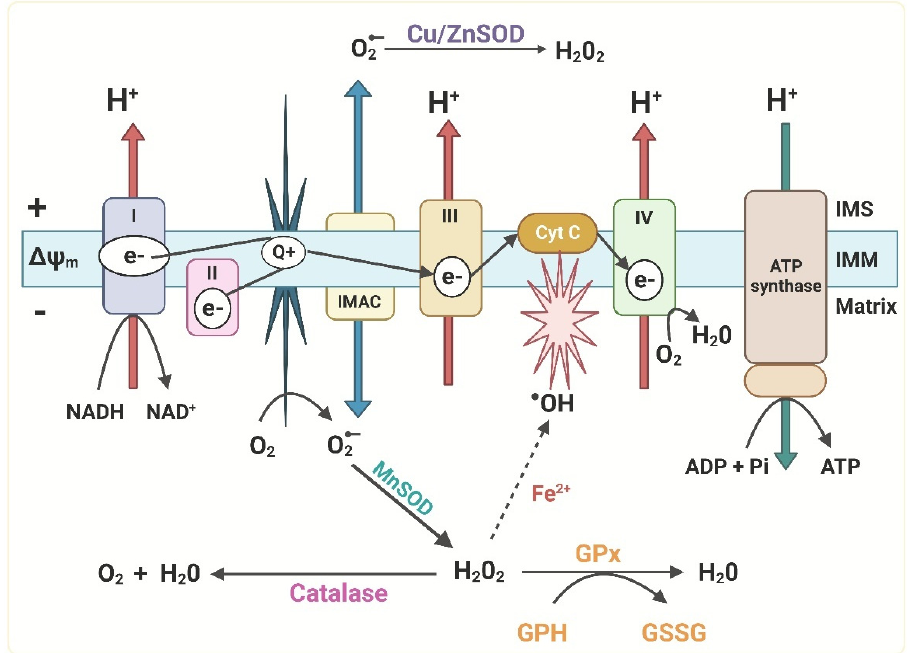
Figure 2. Generation of ROS in the Electron Transport Chain (ETC) and mitochondrial antioxidant defenses. During normal metabolism, small amounts of electrons leak from mitochondrial complexes I and III, generating O2•- production. H 2 O 2 can interact with metal ions through the Fenton reaction (dotted line) and cause a highly reactive compound, •OH, which can damage DNA, pro- teins, and lipids. IMS: intermembrane space; IMM: inner mitochondrial membrane; NADH: Re- duced Nicotinamide Adenine Dinucleotide; NAD + : Oxidized nicotinamide adenine dinucleotide;